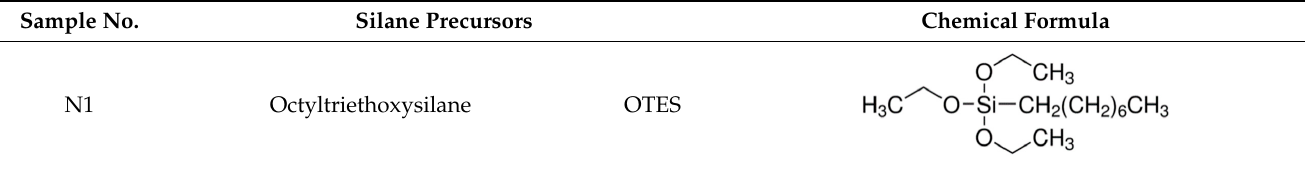
Table 1. Silane precursors and their chemical formulae.